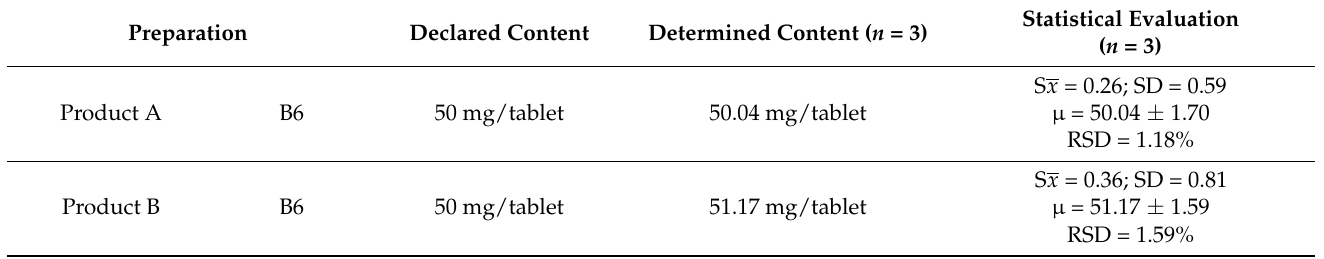
Table 4. The determined content of B vitamins in the analyzed